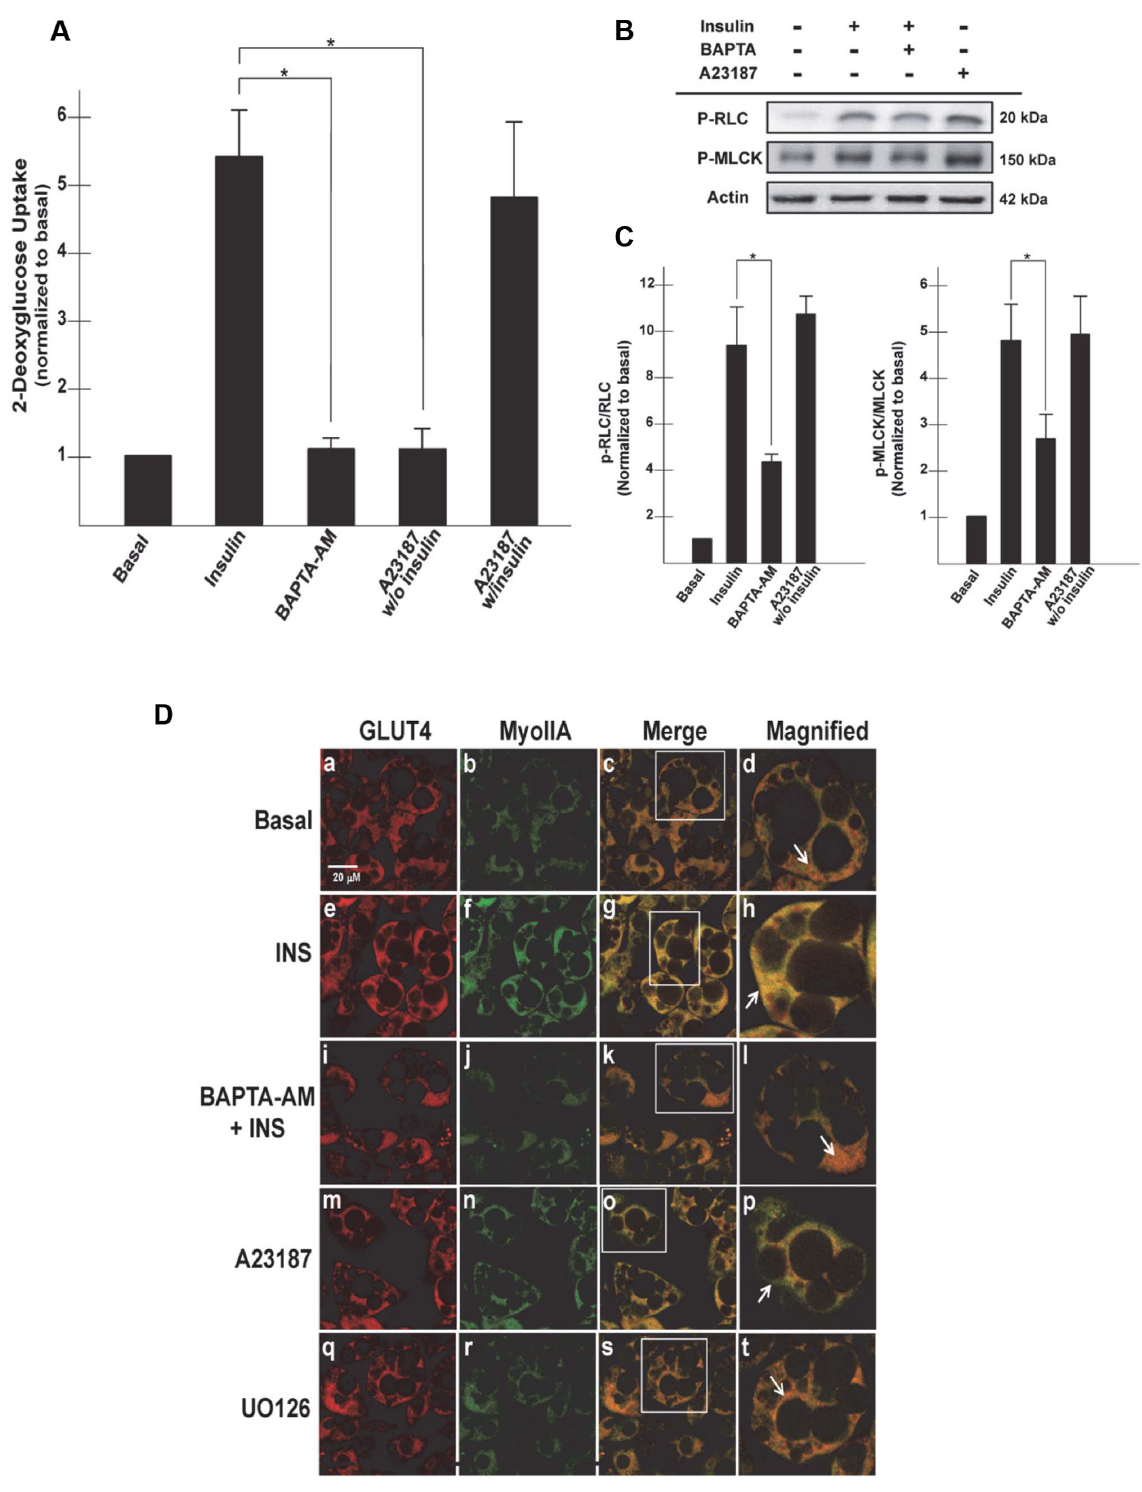
Figure 3. Calcium regulation of MLCK facilitates GLUT4-mediated glucose uptake in 3T3-L1 adipocytes. 3T3-L1 adipocytes were serum starved for 4 h then pretreated with BAPTA-AM (50 m M), A23187 (0.1 m M) or U0126 (25 m M) for 20 min and then either left untreated or stimulated with insulin (100 nM) for an additional 20 min. (A) Cells were untreated (Basal), treated with A23187 alone or insulin stimulated (100 nM) in the presence of A23187 and then incubated with [1- 14 C]-2-deoxy-D-glucose (0.1 m Ci/well) and 5 mM glucose for an additional 10 min. Cells were then lysed and glucose uptake calculated as disintegrations per mg protein and expressed as percent of control. Results are the mean 6 SEM of three independent experiments. Differences between insulin-stimulated cells and treated cells (BAPTA-AM or A23187) were tested for statistical significance (*p , 0.05). (B) Whole cell lysates were prepared, subjected to SDS-PAGE and then immunoblotted using antibodies against either P-RLC or P-MLCK. (C) Determination of band densities was measured using ImageQuant software and are presented as either P-RLC/RLC or P-MLCK/MLCK